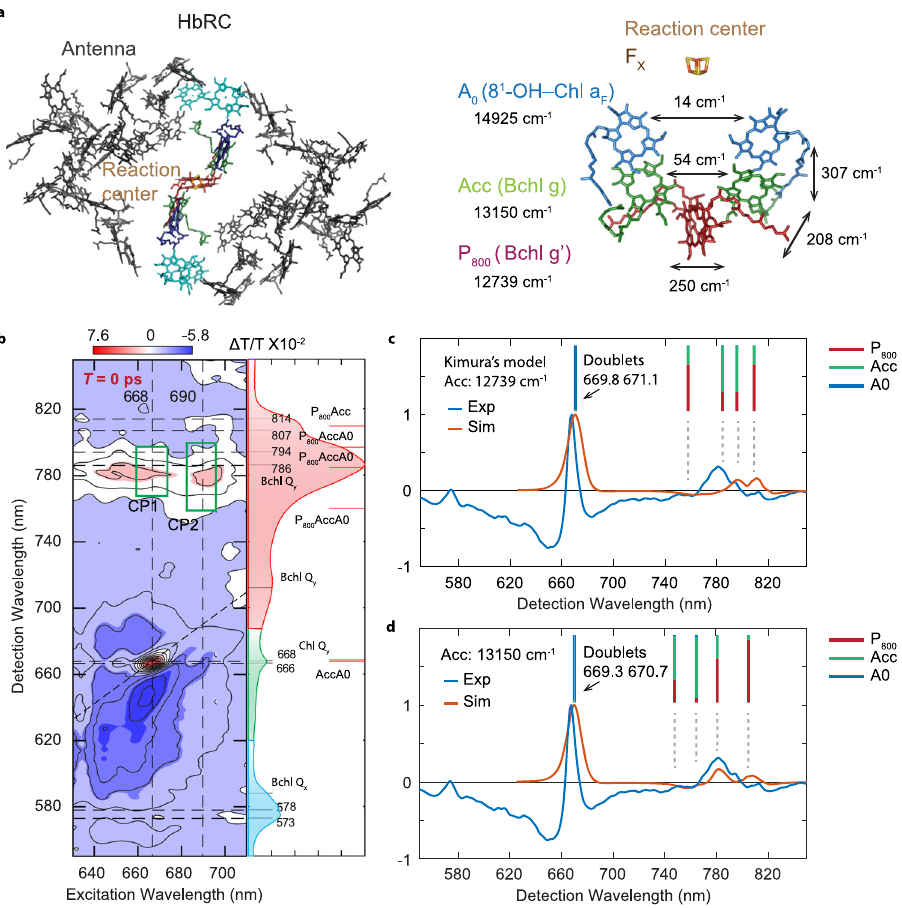
Fig. 1 Experimental and simulated 2DES absorptive spectra at T = 0 ps reveal the excitonic structure of the core RC at 77 K. a The pigment arrangement in the full HbRC (left) and in the core RC (electron transfer domain). The same color scheme is used in the full HbRC and the core RC. The arrows and the numbers on top show the electronic coupling strengths between two pigments. b The experimental 2DES absorptive spectrum at T = 0 ps. Green boxes from left to right indicate two cross-peaks positions (i.e., CP1 and CP2) discussed in the main text. Alongside the 2D absorptive spectra are the experimental absorption spectrum and the simulated stick spectrum (red lines) from Kimura et al 8 . The experimental absorption spectrum is divided into three color-coded regions based on their dominant contributions (i.e., red — the Bchl Q y band; green — the Chl Q y band; blue — the Bchl Q x band). The dashed lines in the 2DES spectrum and the gray lines in the absorption spectrum indicate the various peak positions discussed in the main text. The contour levels are − 1:0.1:1 of the maximum amplitude. c The experimental and simulated slice spectra under excitation of A 0 (slice position shown as vertical dashed line at excitation wavelength = 668 nm) at T = 0 ps extracted from the 2DES absorptive spectra. The site energies of BChl g and BChl g ′ are set to be equal according to Kimura ’ s excitonic model. d The experimental and simulated slice spectra under excitation at 668 nm at T = 0 ps extracted from the 2DES absorptive spectra. Modifying the site energy of accessory BChl g to be 13150cm − 1 yields considerably better agreement with the experimental data. The presence of distinct BChl Q y peaks upon excitation at 668 nm reveals excitonic coupling between A 0 and the BChl pigments Acc and P 800 . The stick bars reveal the participation ratios of the RC pigments in each excitonic state as given in the respective exciton